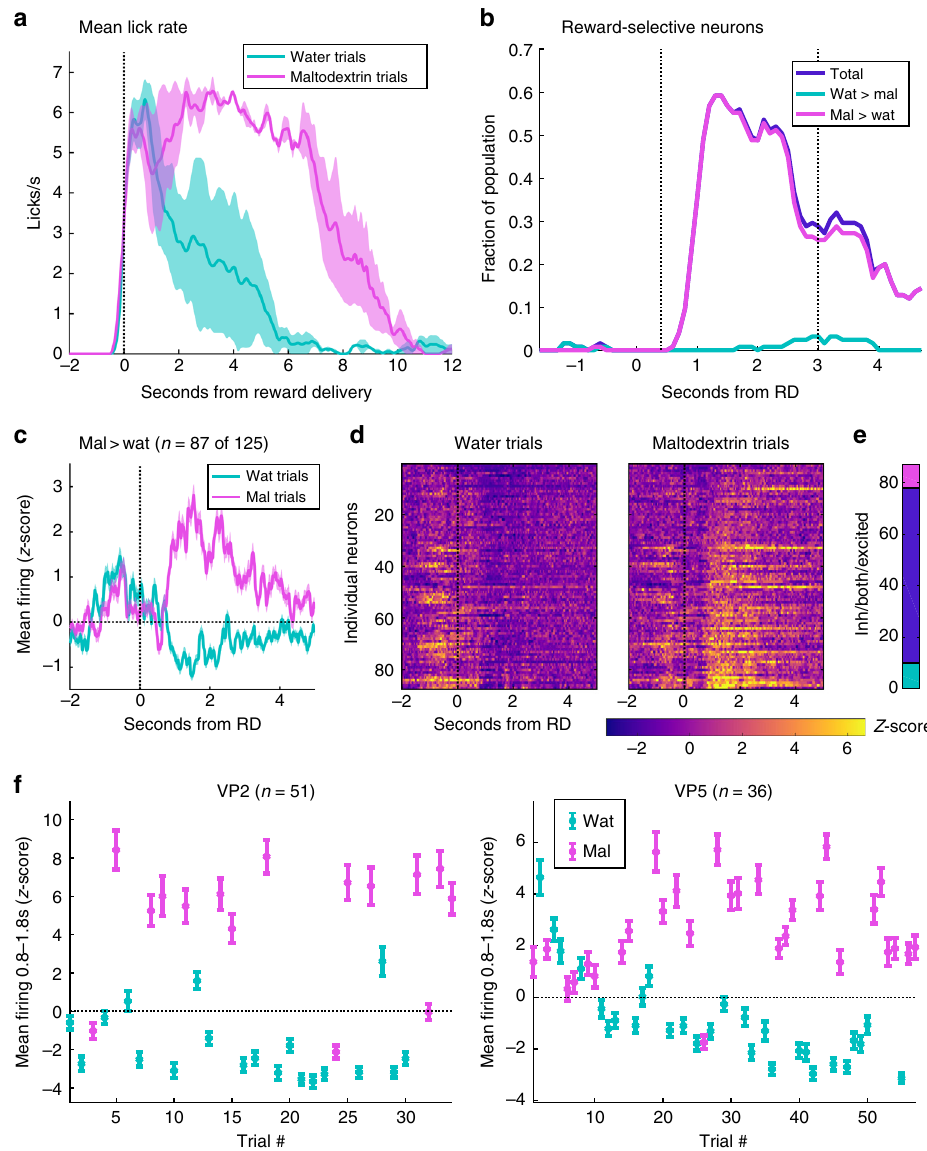
Fig. 5 VP reward-selective activity adjusts to re fl ect relative value of new outcomes. a Lick rate on water (blue) and maltodextrin (pink) trials. Shading is SEM. b Fraction of VP neurons that meet criteria for reward selectivity relative to reward delivery time (as in Fig. 2). Plotted are the total fraction of reward- selective neurons (dark blue) and, of those, neurons with greater fi ring for maltodextrin (pink) and greater fi ring for water (light blue). Dashed lines indicate the window (0.4 – 3 s) for which reward-selective neurons were selected for ( c ) and ( d ). c – e Neurons with greater fi ring for maltodextrin in any of the bins centered 0.4 – 3 s. c Average normalized fi ring rate for these neurons on water (blue) and maltodextrin (pink) trials. Shading is SEM. d Heat maps of the normalized activity of individual neurons on water and maltodextrin trials. e Number of neurons with maltodextrin excitations (pink), water inhibitions (light blue), or both (dark blue). f Emergence of maltodextrin (pink) excitations and water (blue) inhibitions among reward-selective neurons across each completed trial of the session. Plotted as mean normalized activity 0.8 – 1.8 s post reward delivery; error bars are